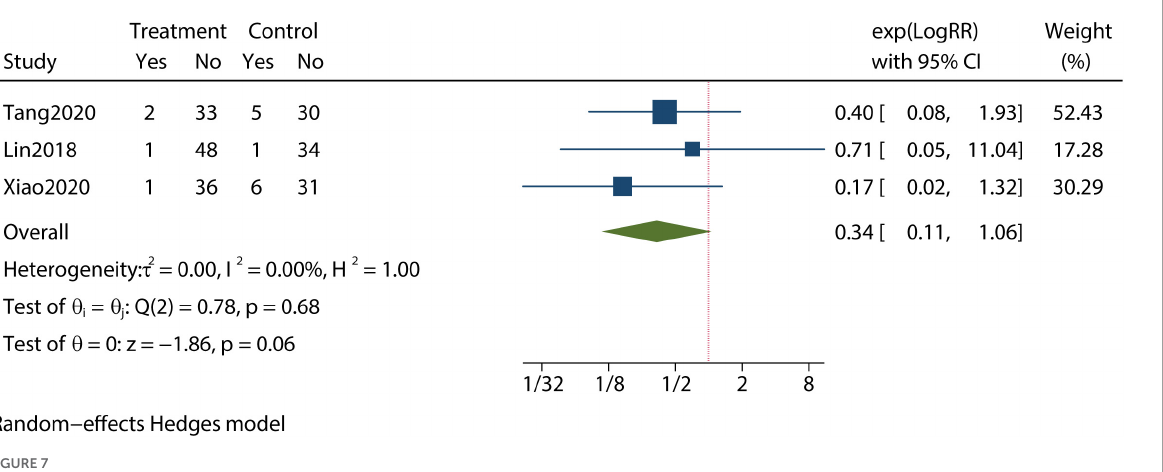
FIGURE7 Meta-analysis of pregnancy loss